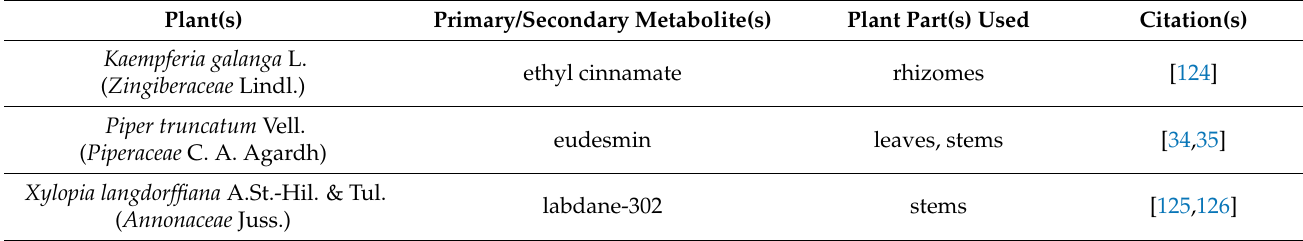
Table 2. Prostacyclin–cyclic adenosine monophosphate activation pathway.